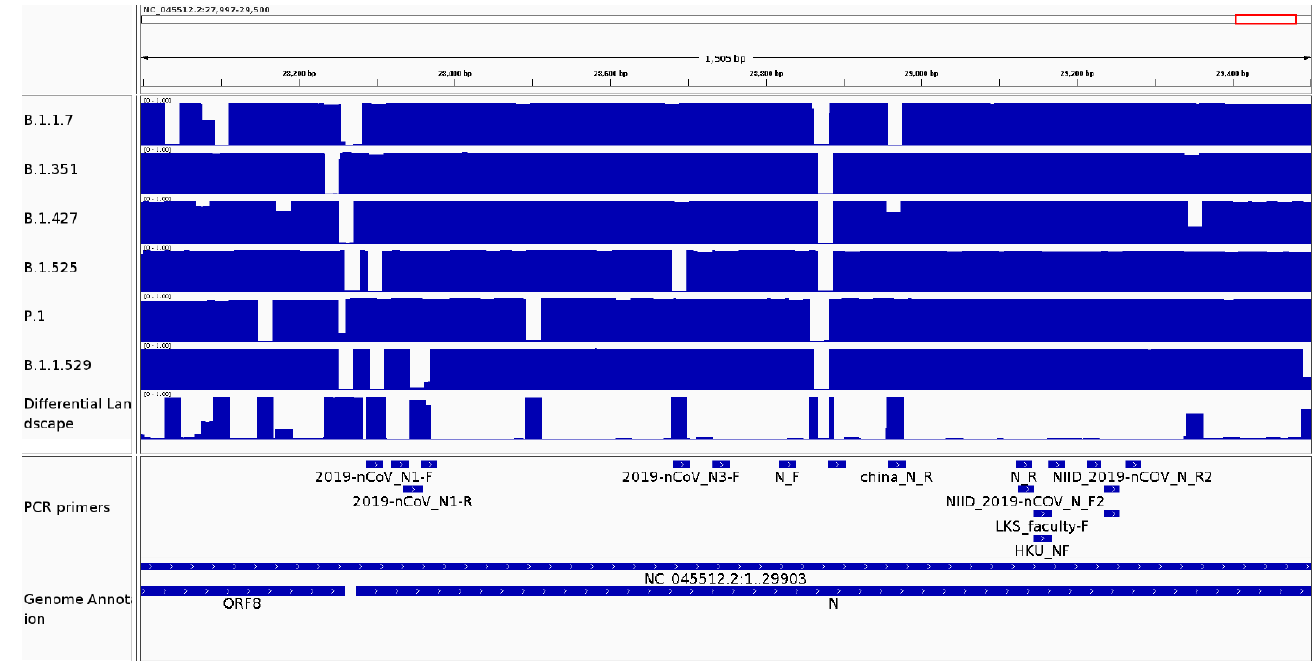
Figure 6. Conservation and differential landscapes for a SARS-CoV-2 region with low conservation in a region targeted by a PCR primer. The visualization generated by CovDif via IGV for the genomic interval 28,000 to 29,500 is shown. Top track: differential landscape showing the biggest difference between all groups; middle tracks: conservation landscape for each SARS-CoV-2 variant; last to bottom track: shows the regions targeted by the PCR primers; and bottom track: SARS-CoV-2 annotation.